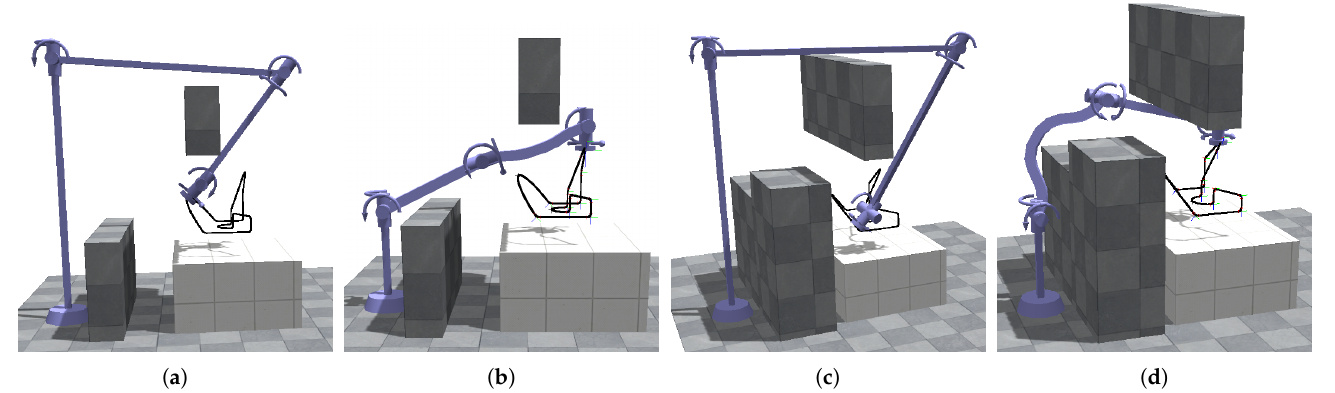
Figure 16. The smallest robots with straight arms able to reach the whole trajectory in the first and second testing workplaces compared to robots with curved arms. ( a ) First workplace, straight arms. ( b ) First workplace, curved arms. ( c ) Second workplace, straight arms. ( d ) Second workplace, curved